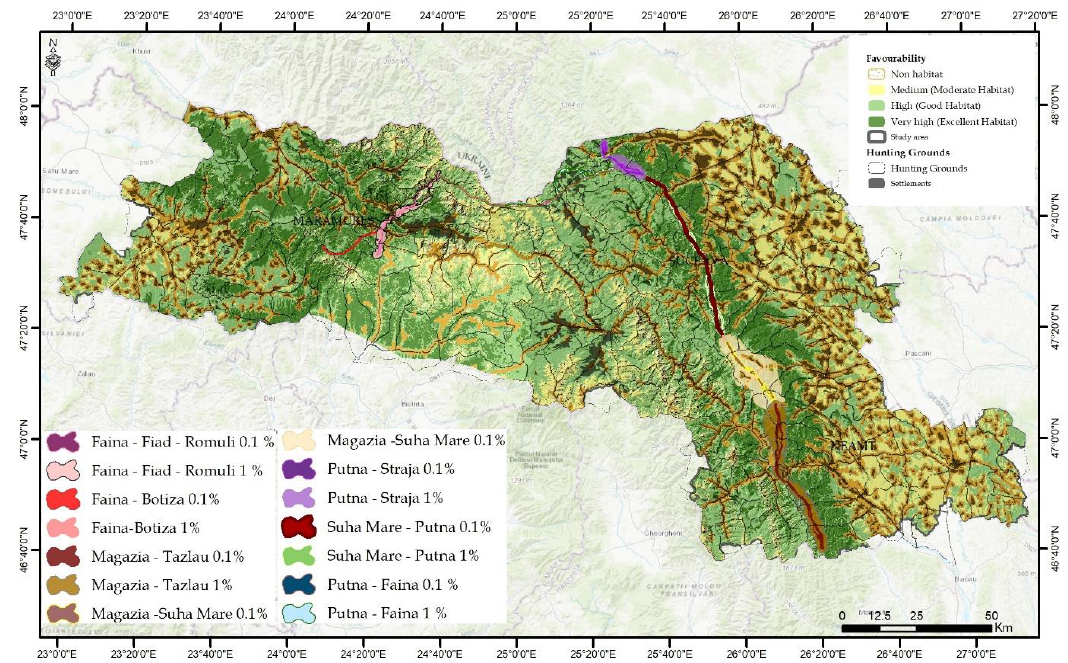
Figure 5. Connection ecological corridors for Bison bonasus L.